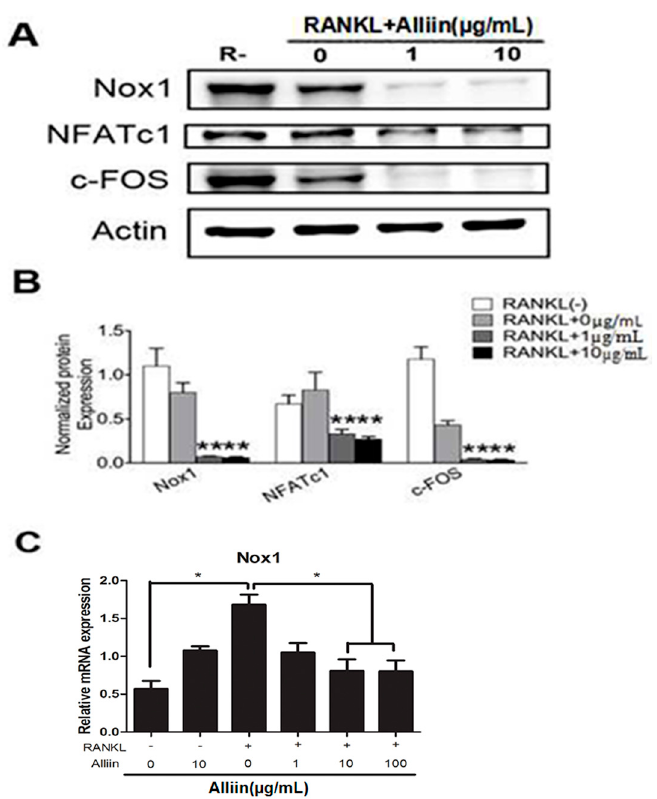
Figure 6. Alliin inhibited RANKL-induced osteoclast differentiation and fusion through inhibiting Nox1 activity and blocking the c-Fos-NFATc1 signaling pathway. Total protein was extracted from RAW264.7 cells during RANKL-induced osteoclastogenesis treated with RANKL (50 ng/mL) and M-CSF (50 ng/mL) for 72 h with varying doses of alliin (0 µg/mL, 1 µg/mL, 10 µg/mL). ( A ) Representative Western blot images of c-Fos, NFATc1, Nox1, and β -actin from RAW264.7 cells in different groups; ( B ) relative intensity of expression level of c-FOS, NFATc1, and Nox1 against β -actin; and ( C ) relative mRNA expression levels of Nox1 against GAPDH. Data in the figures represent the mean ± SD. * ( p -value < 0.05); ** ( p -value < 0.01) based on one way ANOVA.